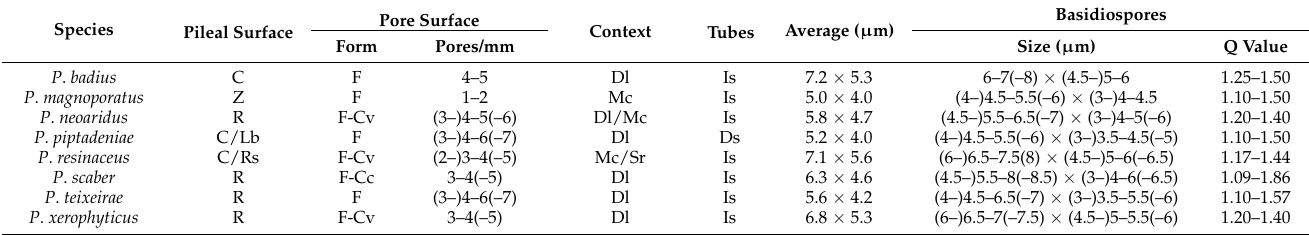
Table 2. Comparison of morphological features in Phellinotus